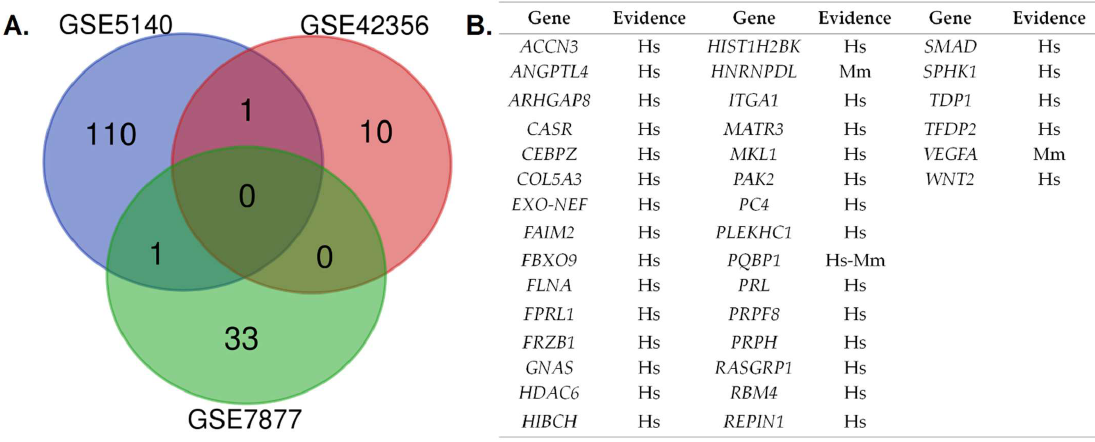
Table 2. Functional annotation and miRNA enrichment analysis of the list of genes from the convergent analysis. Category